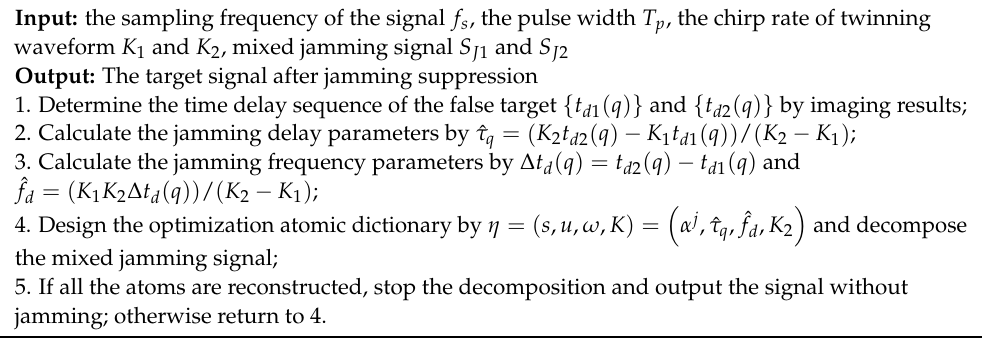
Algorithm 1. Atomic Dictionary Parameter Optimization